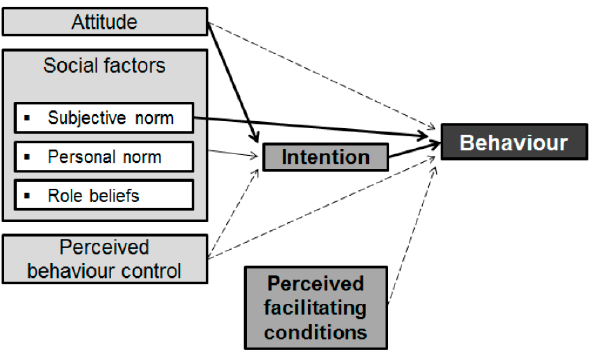
Figure 6. New proposed model to explain upcycling ( → strong influence; → moderate influence; - - > weak influence) [14,15].